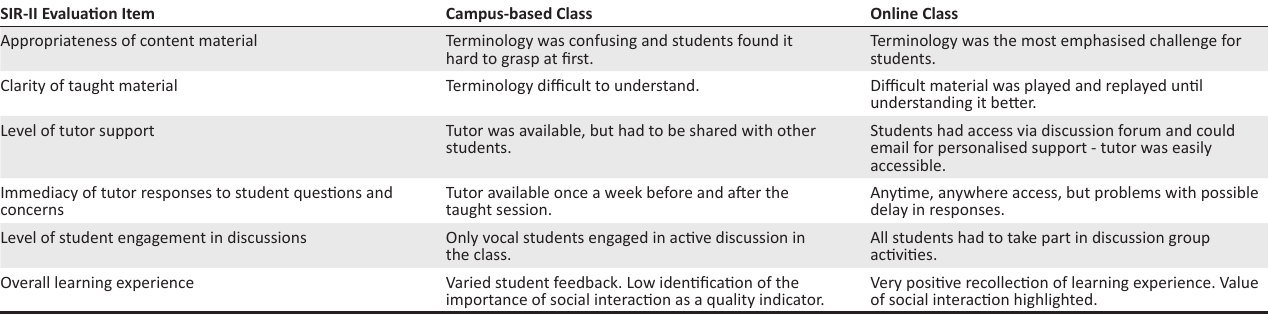
TABLE 2: Emergent themes for the Student Instructional Reporting questionnaire version 2 student evaluation. SIR-II Evaluation